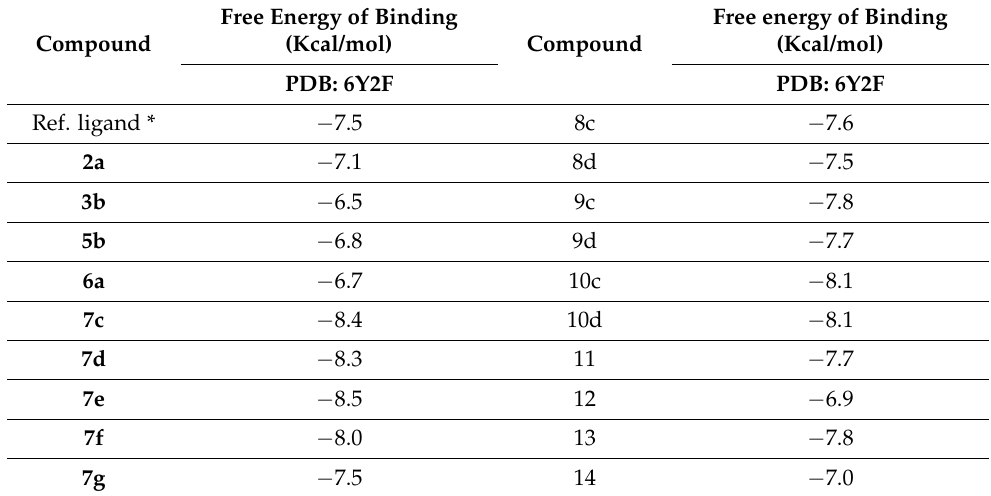
Free energy of Binding